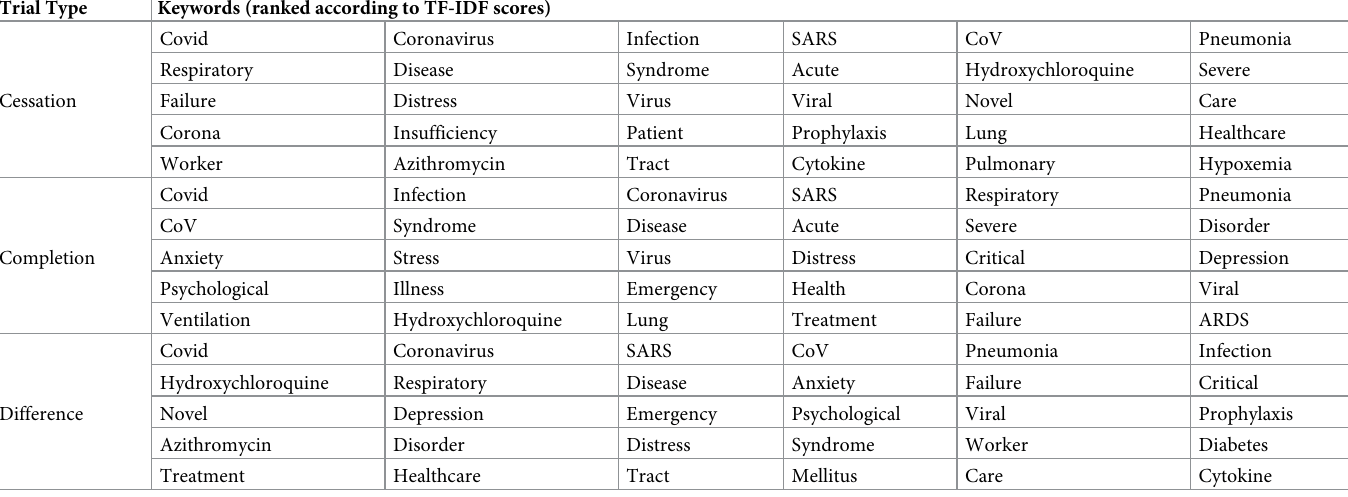
ARDS represents Acute Respiratory Distress